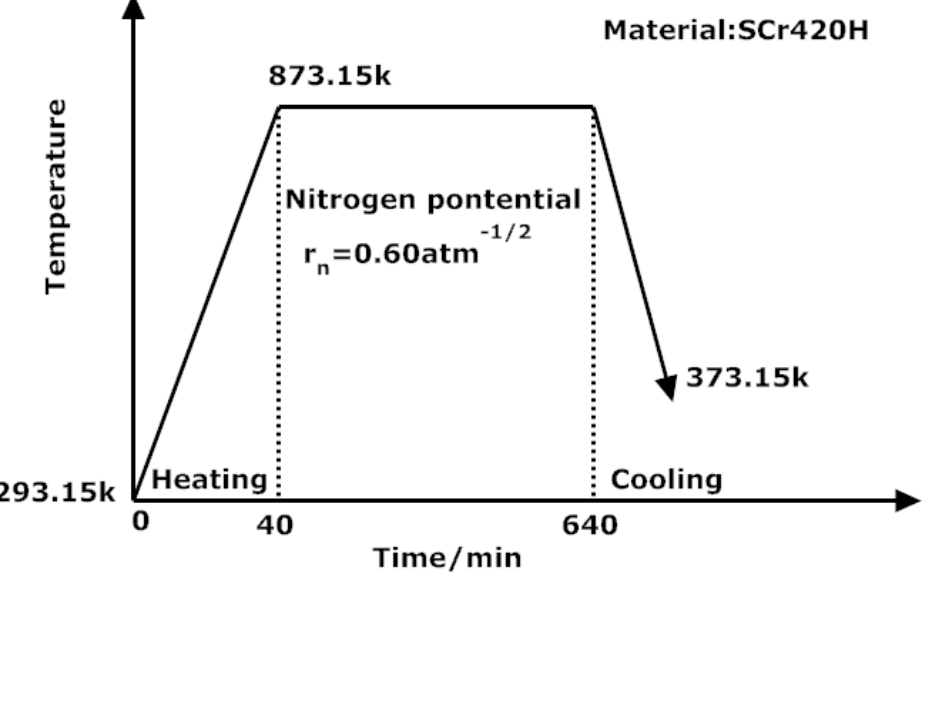
Fig. 3 A schematic illustration for nitriding process in SCr420H steel.